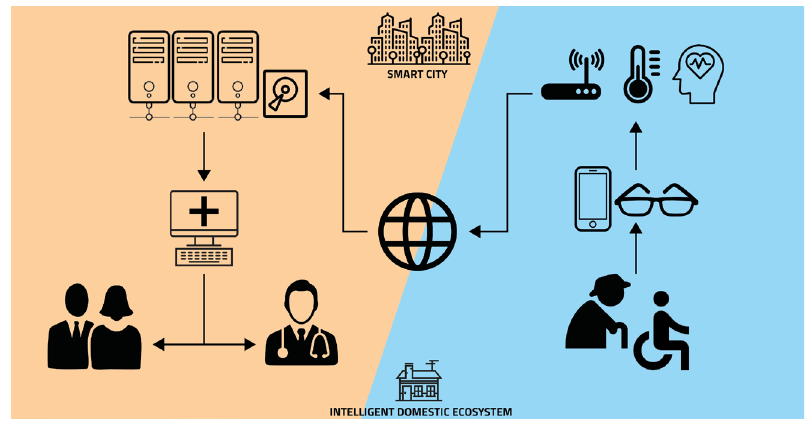
How an Intelligent Home Ecosystem works Source: